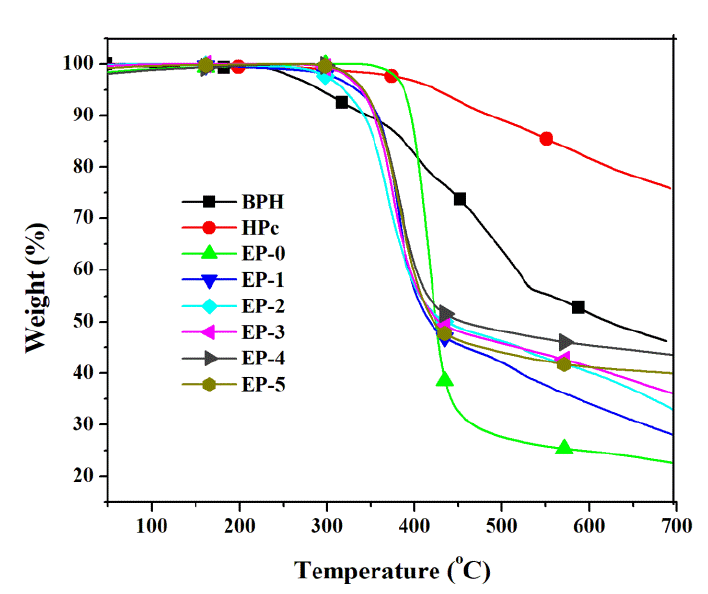
Figure 7. TG curves of epoxy thermosets, BPH, and HPc.